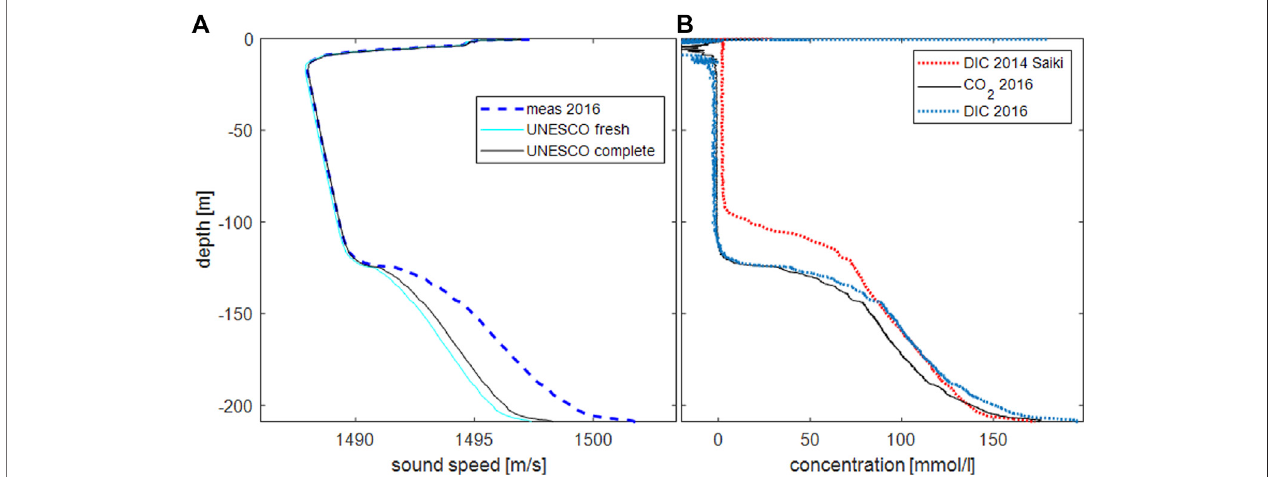
FIGURE3|(A) : Sound speed asmeasured and calculated from temperature, electrical conductivity(either using measured values “ UNESCO complete ” or setting electrical conductivity to zero “ UNESCO fresh ” ) and pressure following UNESCO (Fofonoff, 1986). (B) : pro fi le of calculated carbon dioxide concentrations as derived from the sound speed excess.